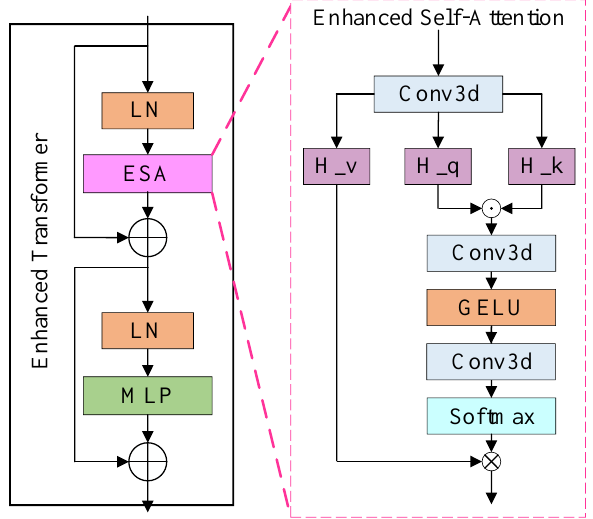
Figure 2. The structure of the enhanced transformer module.